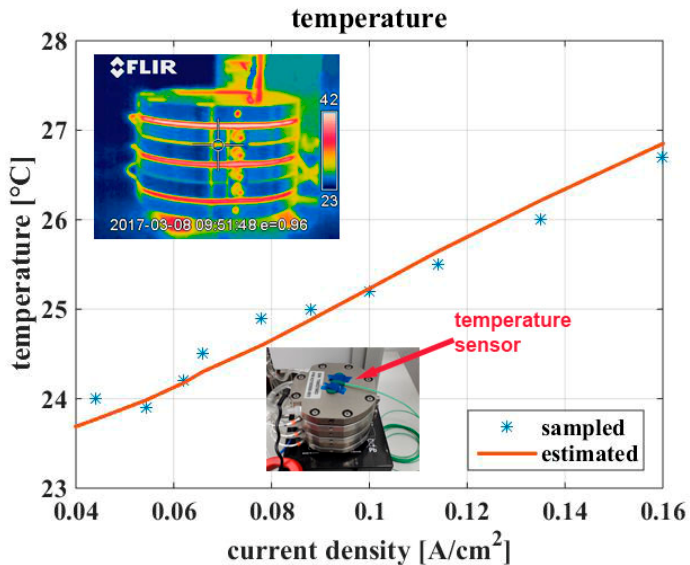
Figure 12. Experimental and estimated temperature of the PEM EL.